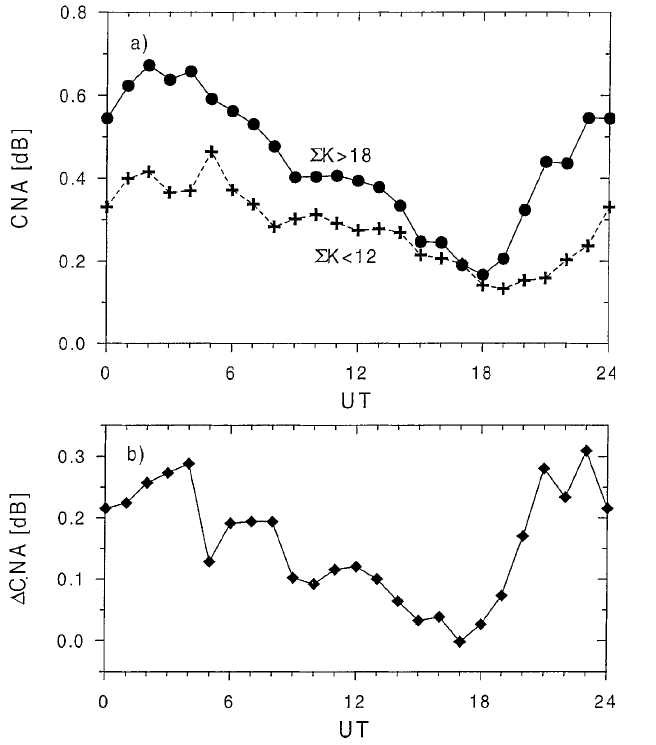
Fig. 7a, b. Mean diurnal variation of CNA at Ivalo for a two di(cid:128)erent levels of geomagnetic activity ( S K < 12 and S K > 18) and b of the di(cid:128)erence D CNA = CNA( S > 18) ) CNA( S < 12) using data from June and July 1994–1997